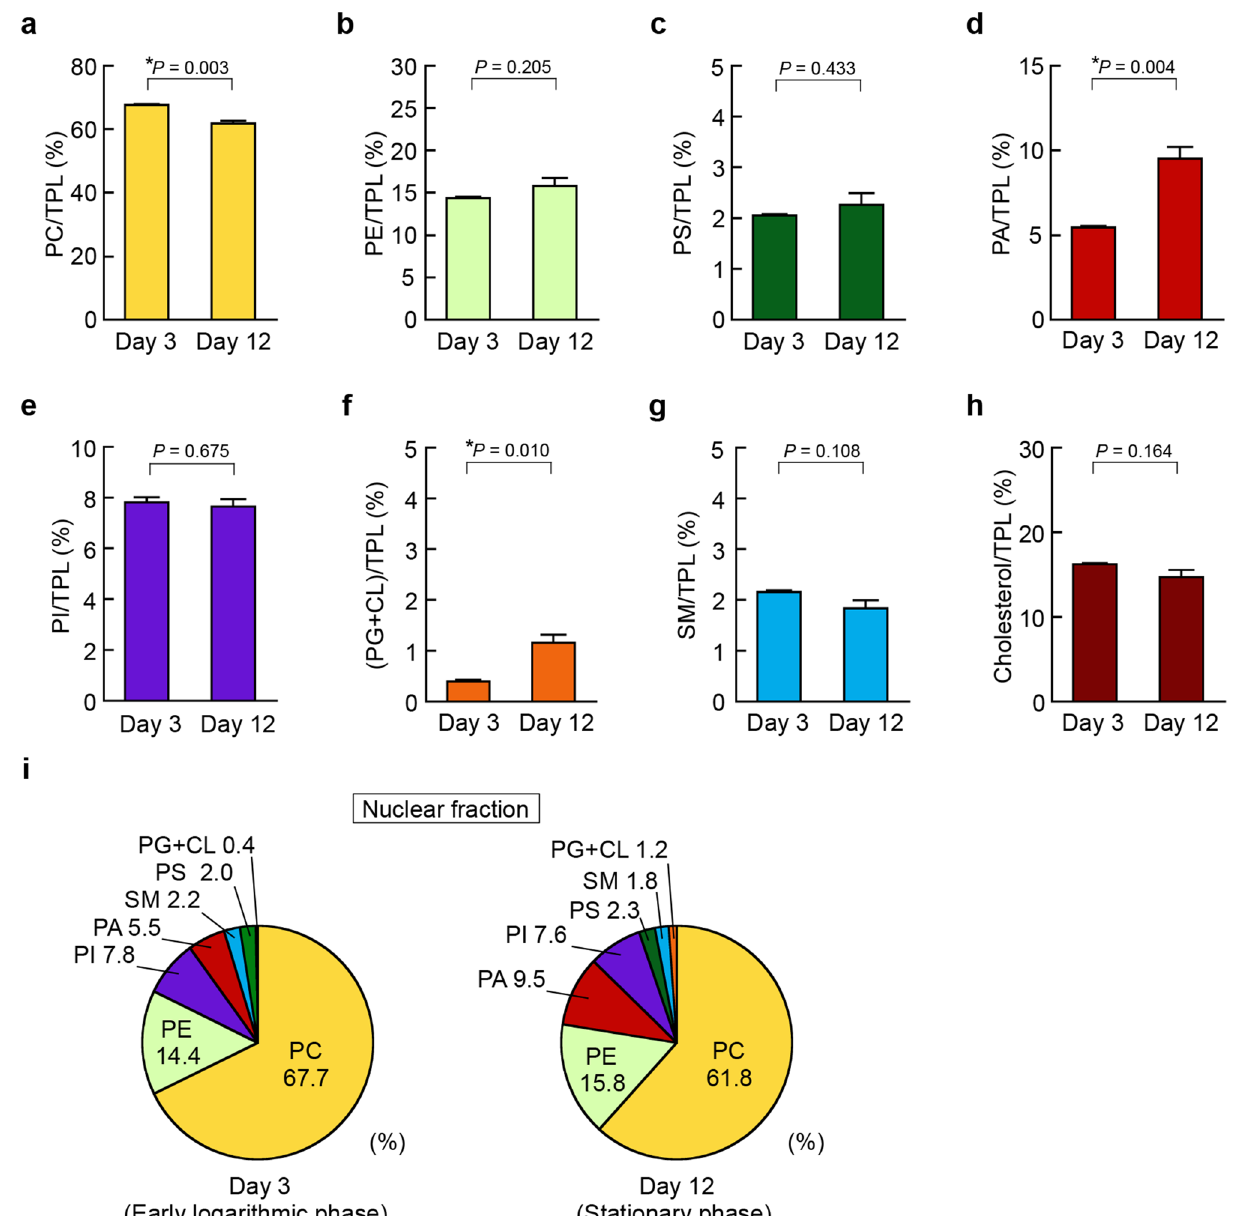
Figure 5. Alteration of nuclear phospholipid composition in HepG2 cells during cell growth. HepG2 cells were seeded at a density of 5.0 × 10 4 cells/cm 2 in 150-cm 2 flasks and cultured in DMEM containing 10% FBS at 37 °C for the indicated days. At Day 3 (early logarithmic phase) and Day 12 (stationary phase), nuclear fractions were isolated from the cells, and nuclear lipids were extracted. The total phospholipid (TPL) content was calculated as the sum of PC, PE, PS, PA, PI, PG + CL and SM contents. The ratios of PC/TPL ( a ), PE/TPL ( b ), PS/TPL ( c ), PA/TPL ( d ), PI/TPL ( e ), (PG + CL)/TPL ( f ), SM/TPL ( g ) and cholesterol/TPL ( h ) in the nuclear fractions purified from the cells at Day 3 and Day 12 were determined by the enzymatic measurements (mean ± S.E., n = 3, * P < 0.05, significantly different between Day 3 and Day 12, unpaired two-tailed Student’s t -test). ( i ) The phospholipid compositions of the purified nuclear fractions from HepG2 cells at Day 3 and Day 12 are shown as pie